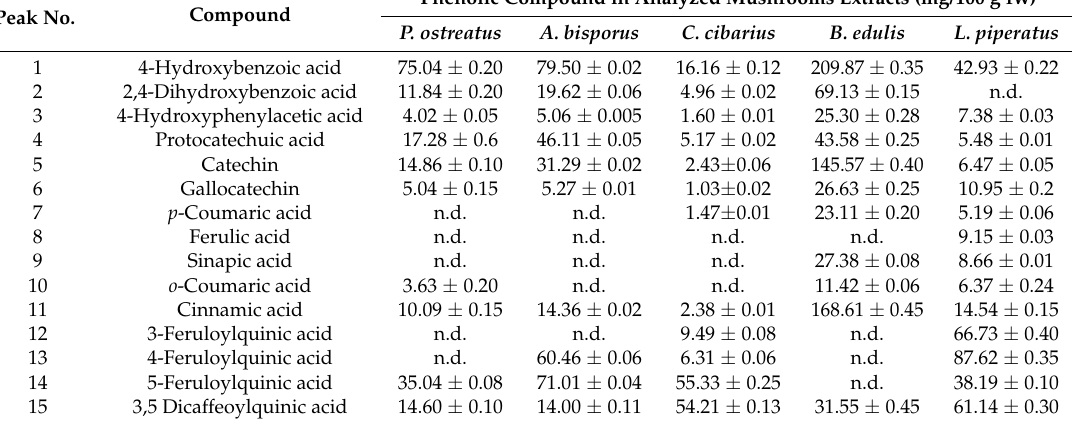
Table 4. The phenolic content in analyzed mushrooms extracts determined by HPLC–DAD and expressed as mg gallic acid equivalents per 100 g · fw (fresh